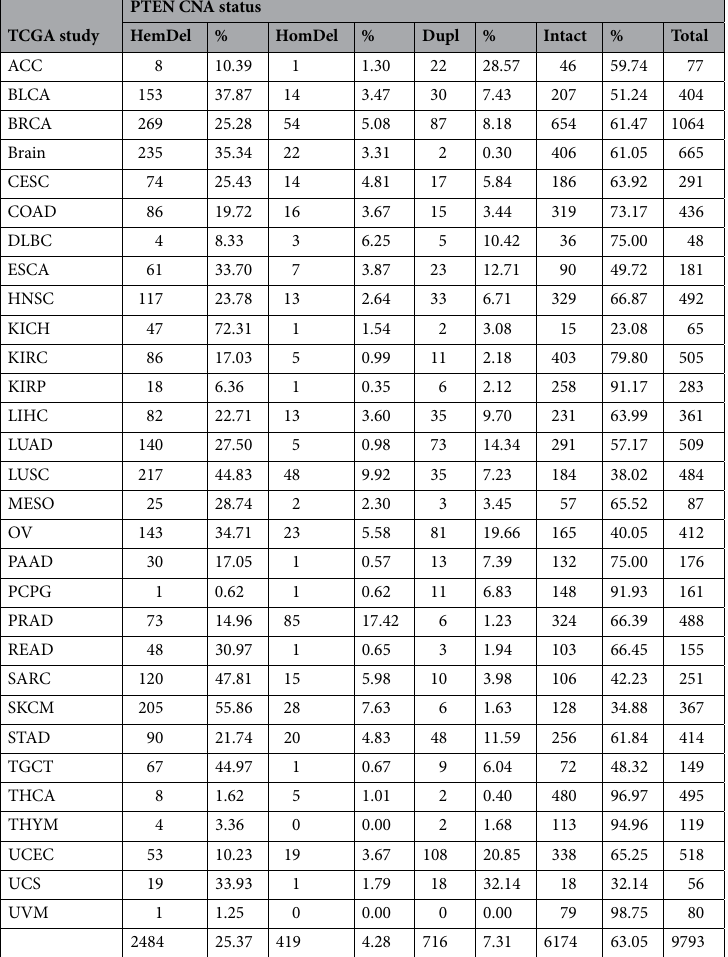
Table 1. PTEN somatic copy number status (SCNA). HemDel: PTEN hemizygous deletion. HomDel: PTEN homozygous deletion. Dupl Duplication or gain across the Pan-cancer cohort of 30 tumors.